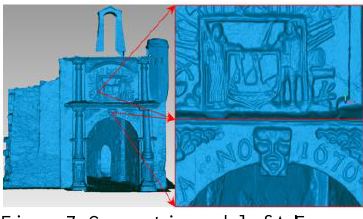
Figure 7. Geometric model of A'Famosa